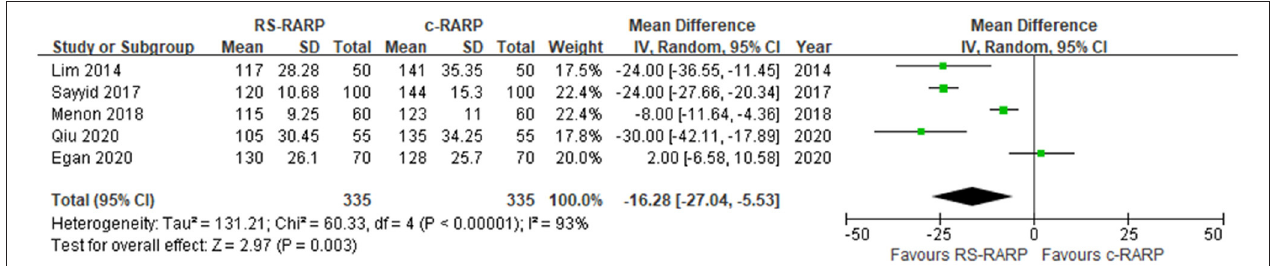
FIGURE 2 | Forest plot of console time.